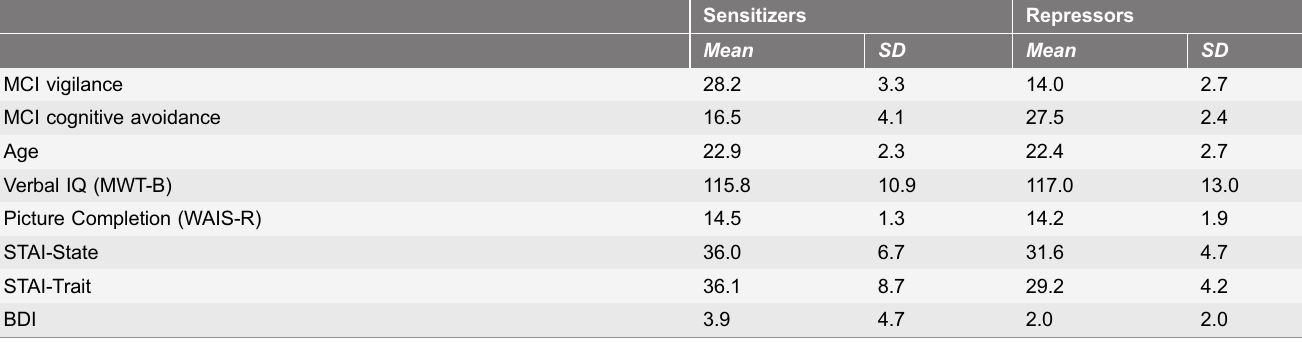
Table 1. Descriptive characteristics of study